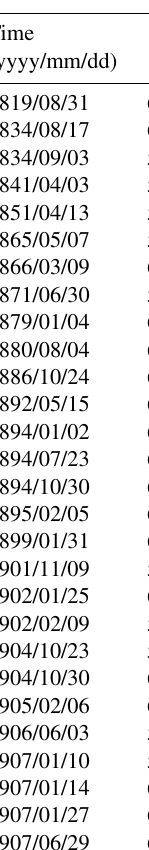
Table A1. Earthquakes with M ≥ 4.5 in the time period 1800– 2021CE within the polygon shown in Fig. 3, extracted from the NNSN earthquake database. Abbreviations: lat: latitude, long: lon- gitude, M : magnitude, type: magnitude type, M l : local magnitude and M w : moment magnitude. For events with both M l and M w available, the largest is presented. ∗ is the magnitude derived from macroseismic data (Mäntyniemi et al.,